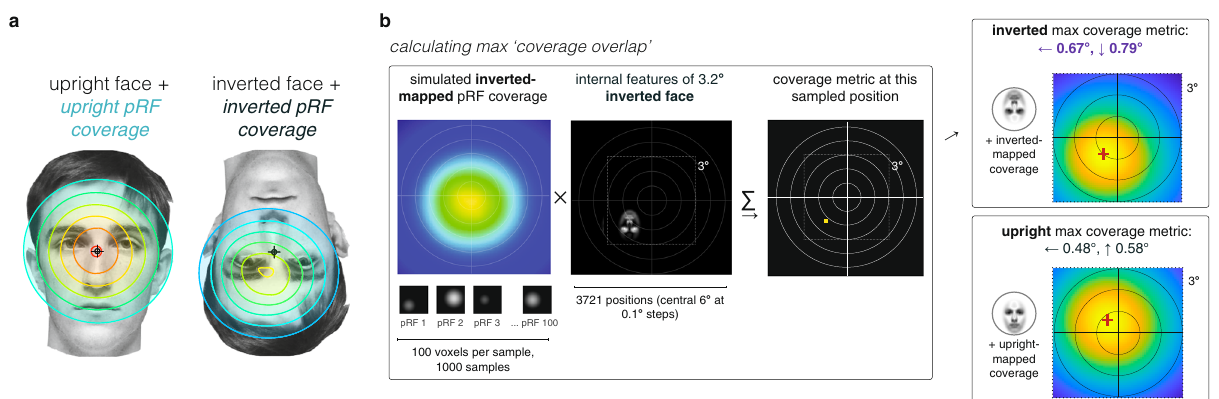
Fig. 6 Using visual fi eld coverage of face-selective regions to predict the location of improved performance for inverted faces. a Schematized depiction of upright- and inverted-mapped mFus-faces pRF coverage when one views example faces centered on fi xation. This predicts that viewing inverted faces yields suboptimal coverage of the location of the face features by pRFs in face-selective regions, which may contribute to the reported behavioral detriments in recognizing inverted faces (e.g., the face inversion effect, or FIE). b To evaluate the hypothesis schematized in a , we used a simulation procedure (see Methods) to determine the location in the visual fi eld that would produce maximal pRF overlap with the internal features of 3.2° faces. To do so, we iteratively sampled a subset of mFus-faces voxels to generate bootstrapped coverage in response to inverted or upright faces; we then took the dot product of this bootstrapped coverage and a face centered at various retinotopic positions (central 3° × 3°, sampled at 0.1° steps). The retinotopic location that yielded the maximal overlap (dot product) between the inverted face and inverted-mapped pRF coverage of mFus-faces, as well as the upright face and upright-mapped coverage, is shown in the right panels. The individual depicted provided informed consent for publication of their